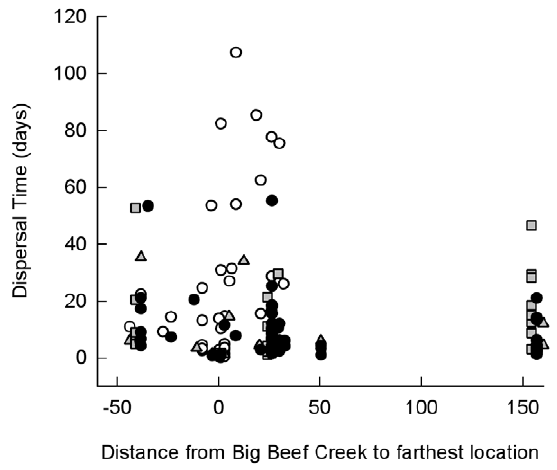
Figure 5. Dispersal time plotted against distance from Big Beef Creek to each smolt’s farthest detection location. Dispersal time is the time between the last estuary detection and the farthest detection. Negative distances represent movement to southern locations, and positive distances represent movement to northern locations. Locations of cutthroat smolts are represented by dark circles, phenotypic cutthroat hybrids are represented by shaded triangles, phenotypic steelhead hybrids are represented by shaded squares, and steelhead are represented by white circles. Locations of some fish were changed slightly to accommodate viewing of all